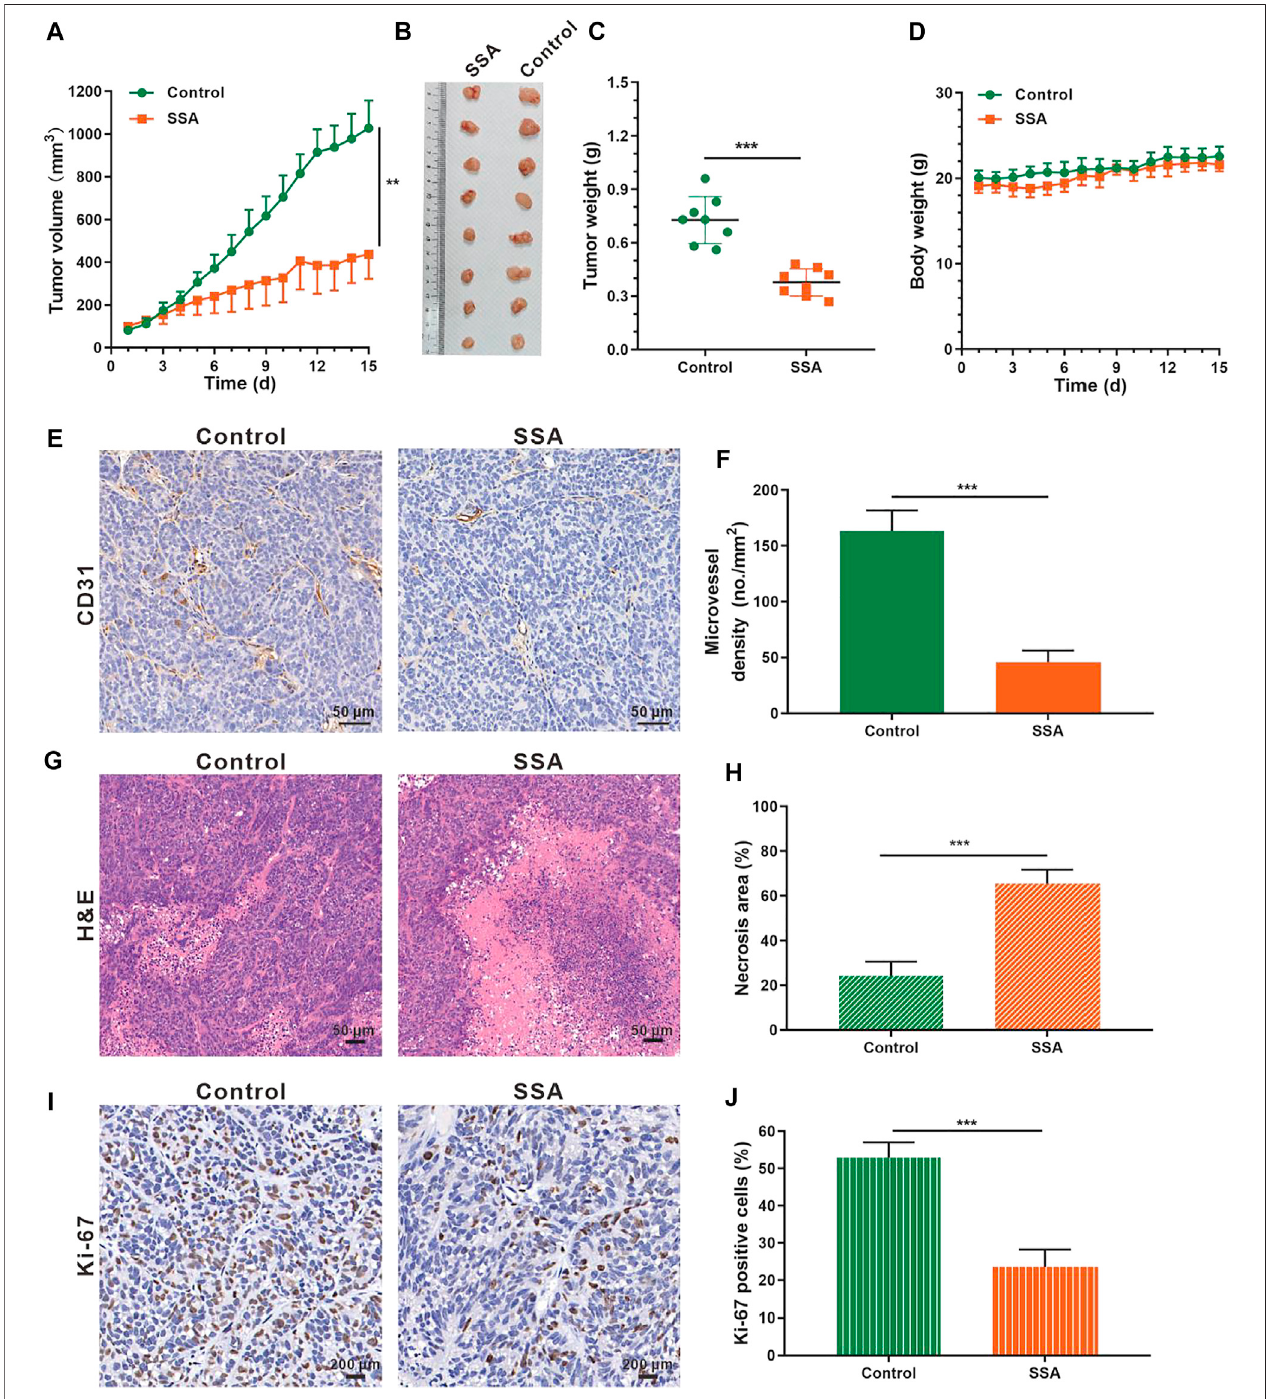
FIGURE 6 | SSA suppressed HCT-15 tumor growth by inhibiting tumor angiogenesis. When the tumor volume reached ∼ 100 mm 3 , the mice were treated intraperitoneally with saline or SSA (10 mg/kg) every day for consecutive 15 days. (A) Tumor growth curve. (B) Photographs of the excised tumor on day 15. (C) Tumor weight on day 15. ( D ) Mouse body weight during the therapy. (E) Representative images of the immunohistochemical staining of CD31 + tumor vessels. (F) Quanti fi ed analysisoftumormicrovesseldensity(MVD). (G) H&Estainingofthetumorsshowedthenecrosisregion. (H) Quanti fi ednecrosisareaassay. (I) Thebrownnucleiof proliferativetumorcellswerestainedwithanti – Ki-67antibody. (J) StatisticalassayoftheKi-67positivetumorcellsinpanelI.Allvalueswereshownasmean ± s .d. n (cid:1) 8in A, C, and D. n (cid:1) 5 in F, H, and I. ** p < 0.01, *** p < 0.001. SSA inhibited angiogenesis by suppressing the VEGFR2 signaling pathway and Its downstream proteins.